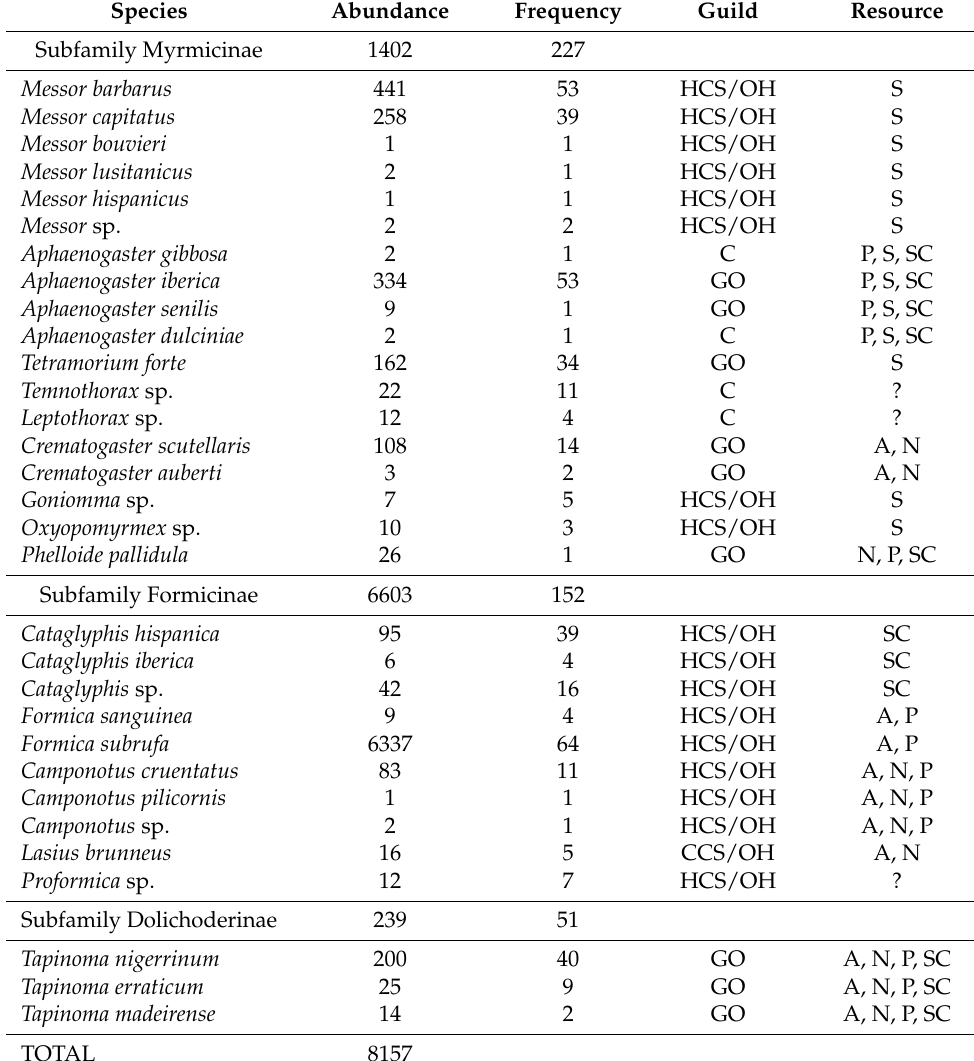
Table 1. Studied material with records of abundance, frequency (number of pitfall traps in which each species was recorded), their functional group (following Roig and Espadaler [24]: HCS/OH = hot and/or open habitat specialists, CCS/SH = cold and/or shadow habitat specialists, GO = Generalist and/or opportunist, C = cryptic), and their main food resource (A = aphid secretions, N = nectar, P = predator, S = seeds, SC = scavenger and